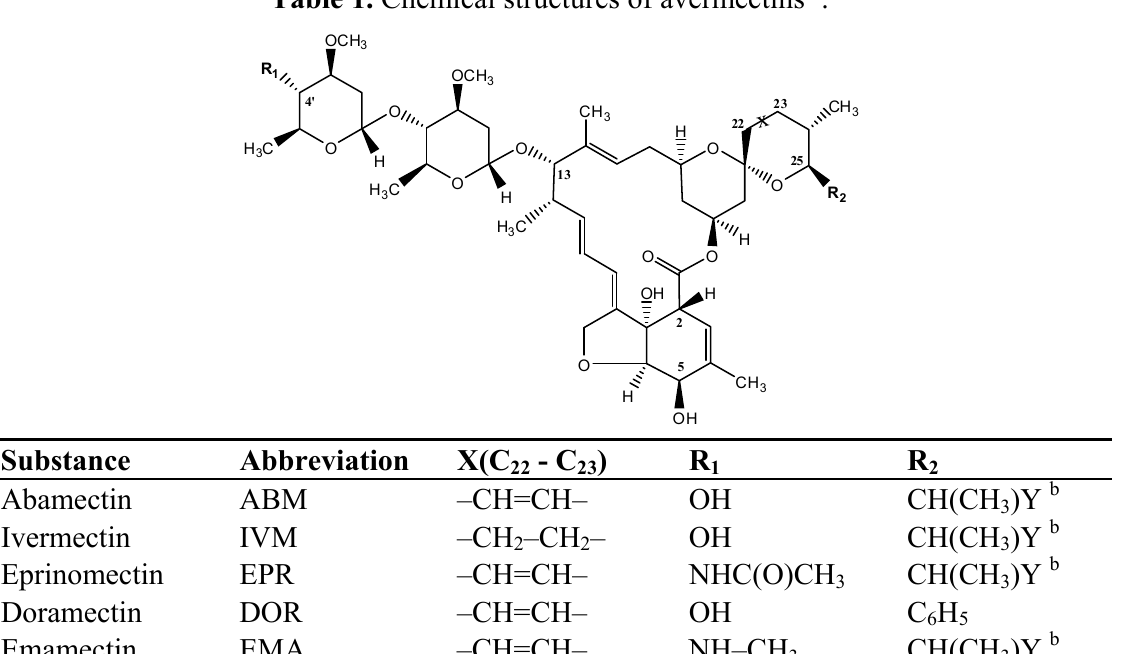
Table 1. Chemical structures of avermectins a